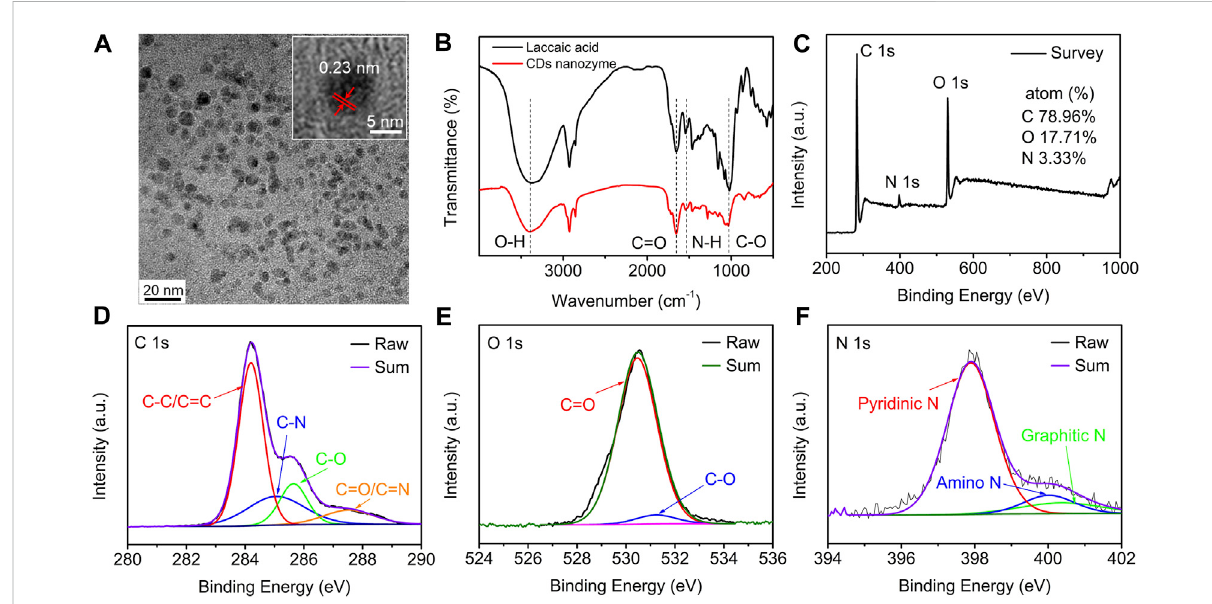
FIGURE 1 (A) TEMimage(inset:HRTEMimage)ofCDsnanozyme. (B) FT-IRand (C) XPSspectraoftheCDsnanozyme. (D) HRXPSC1s, (E) O1s,and (F) N1s spectra of CDs nanozyme and fi tting